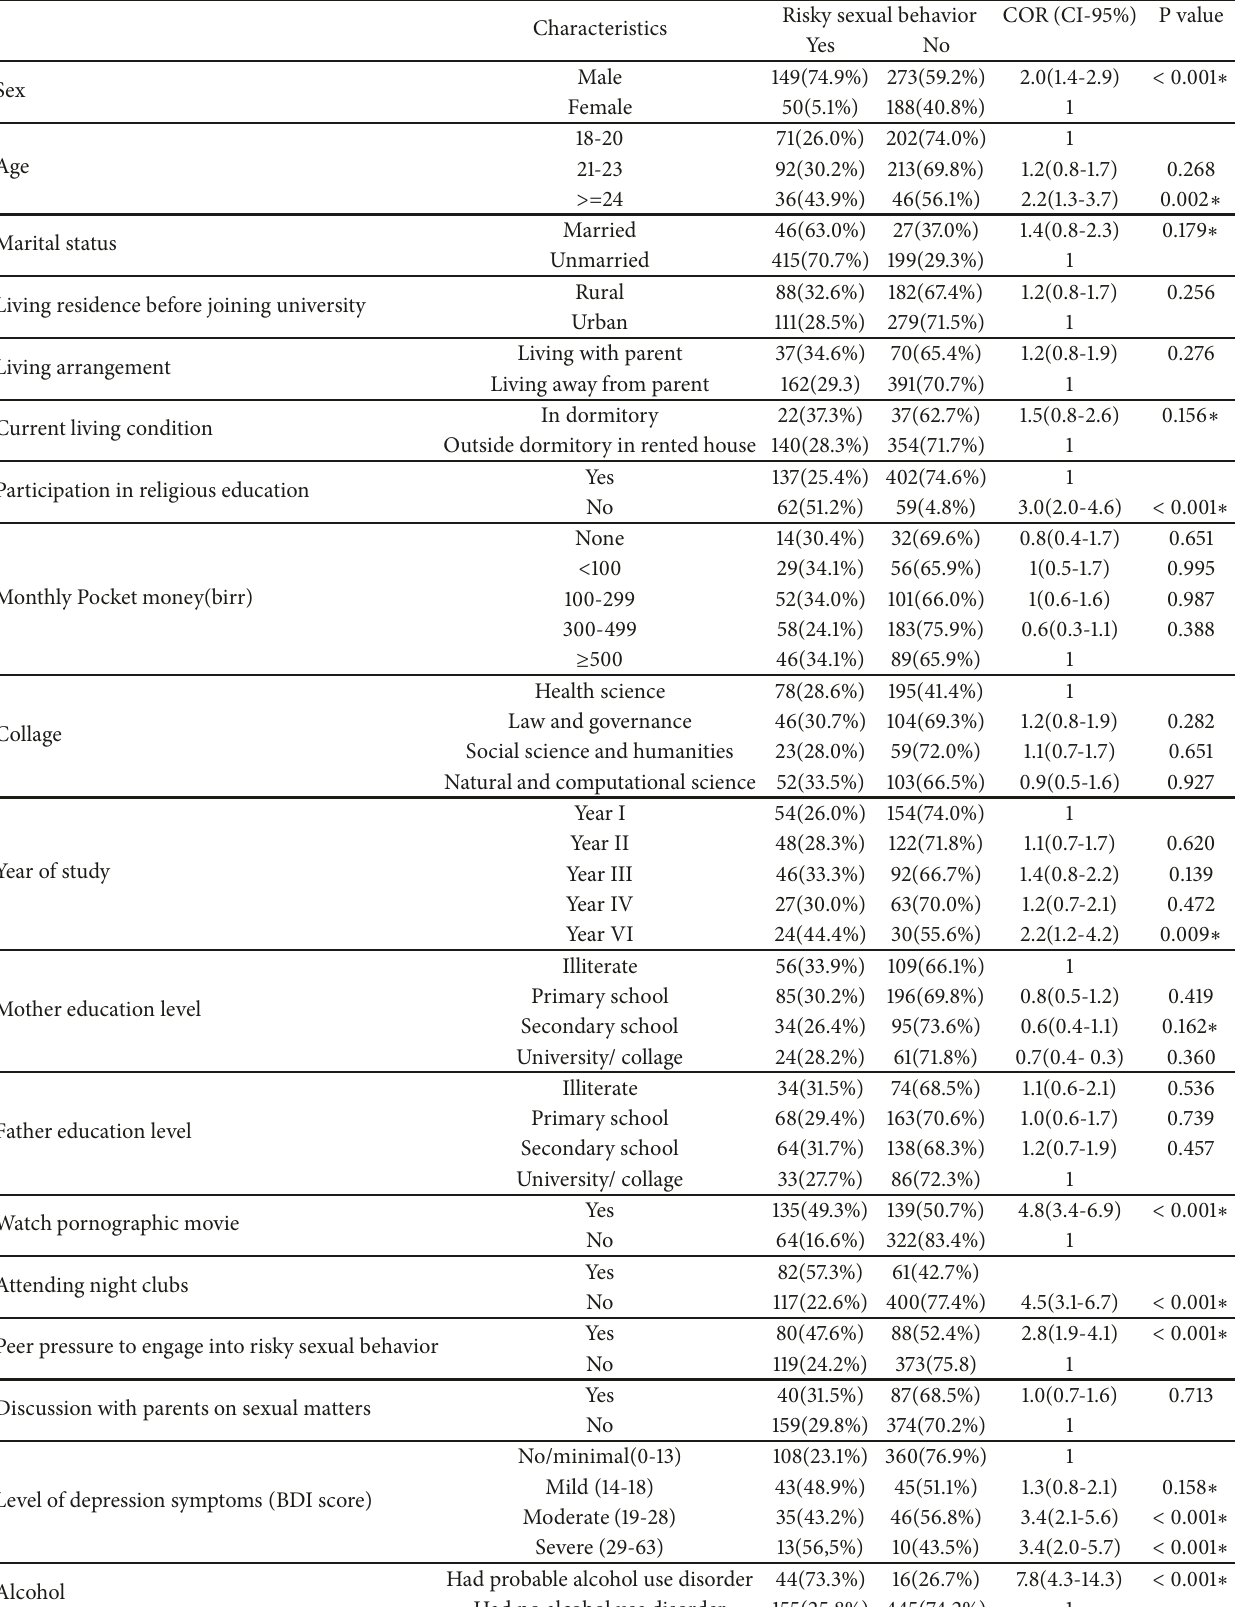
Table 4: Bivariate analysis of factors associated with risky sexual behavior among Jimma university students, April